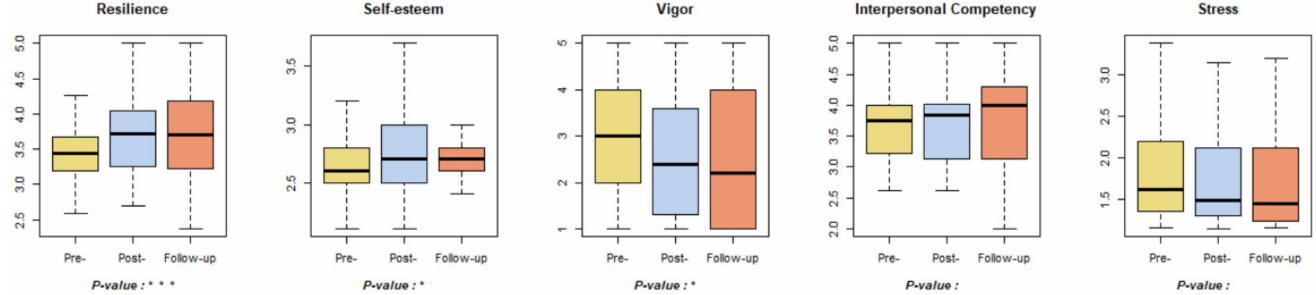
Figure 10. Results of mental health-related indicators. * p < 0.05, *** p < 0.001. Pre-: daily health conditions two weeks prior to the forest healing program; Post-: health conditions immediately after the forest healing program; Follow-up: daily health conditions one, two, and four weeks after the forest healing